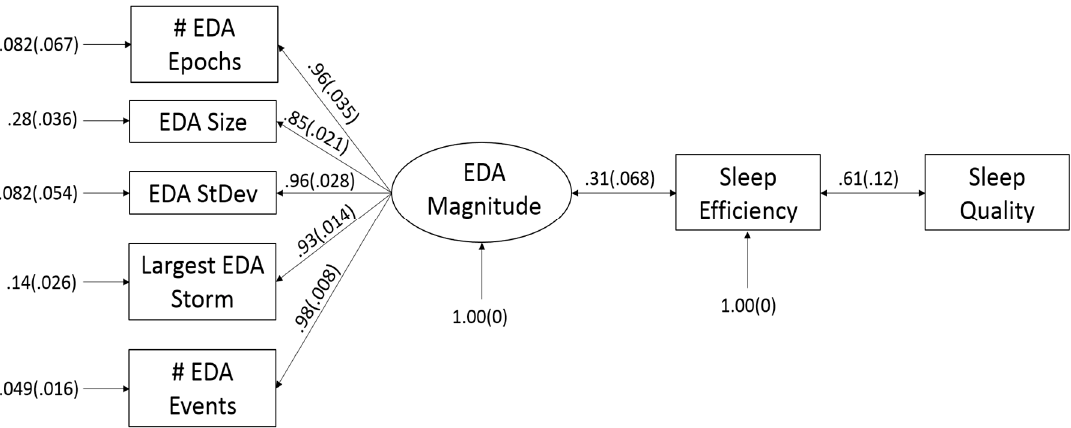
Figure 2. Path diagram of the causal relationship between EDA features extracted from the E4 sensor, reported sleep efficiency, and reported sleep quality. Standardized coefficients are reported. All are significant at the 0.05 alpha level.